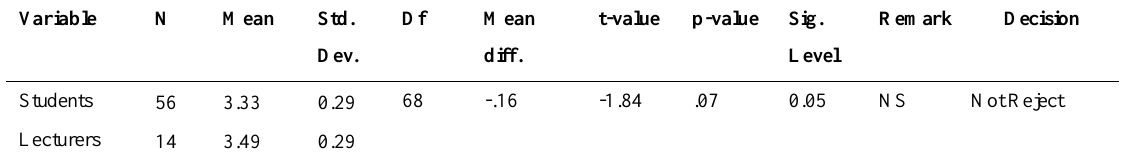
Table 8: t-test analysis of the grand mean responses of lecturers and students on consequences of insecurity on the people of Enugu State Variable